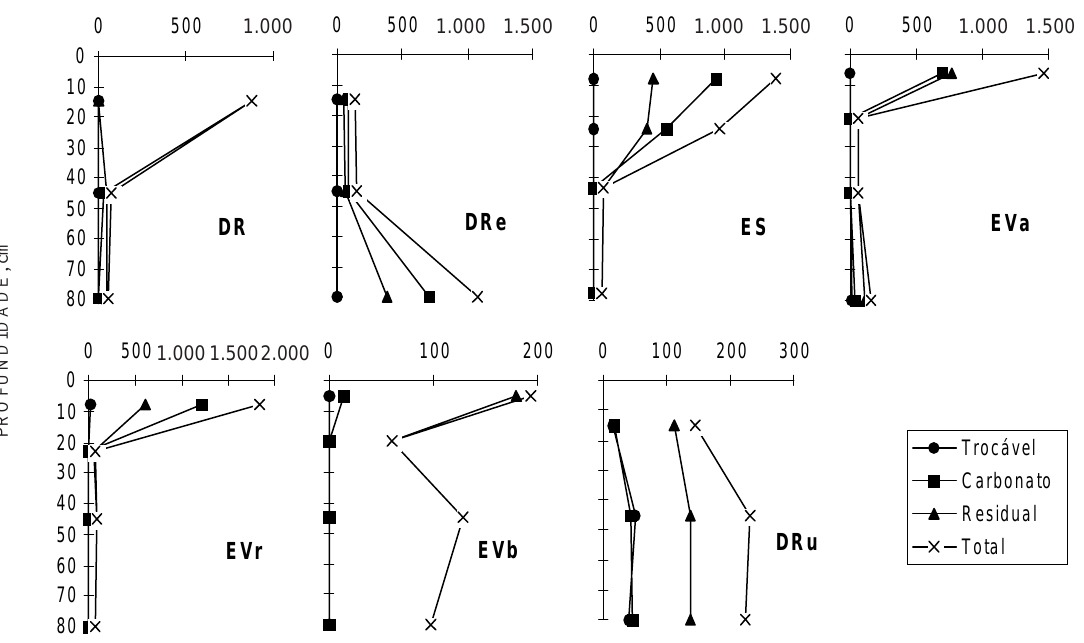
Figura 4. Formas químicas e teores de Cu no solo nos diversos locais e profundidades amostradas. Legenda: ver figura